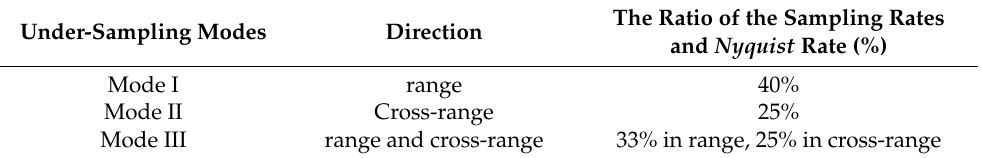
Table 3. Setting of the under-sampling